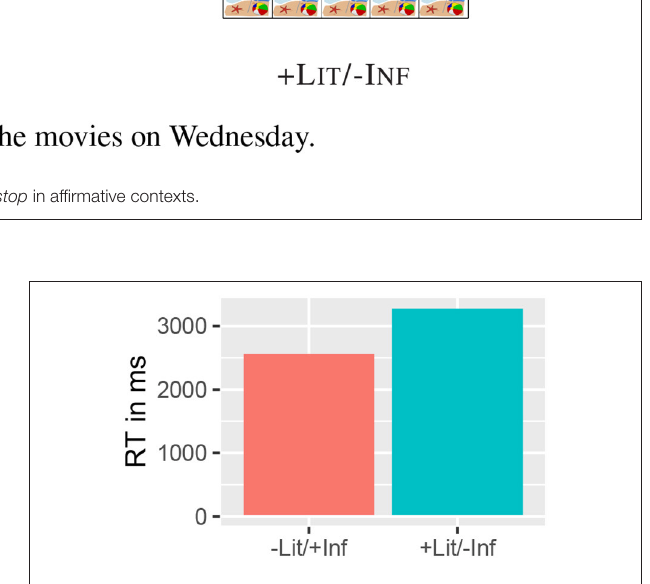
FIGURE 11 | Experiment II (“stop”) RTs for rejections in the Inference False and Inference True